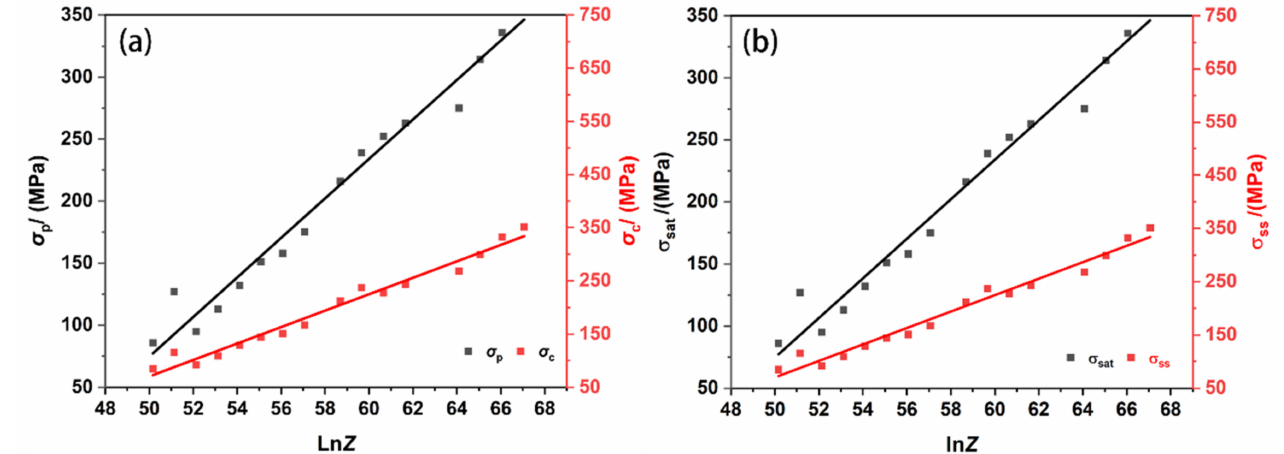
Figure 5. Relationship between: ( a ) ln Z and the stress ( σ p and σ c ), and ( b ) ln Z and the stress ( σ sat and σ ss ).